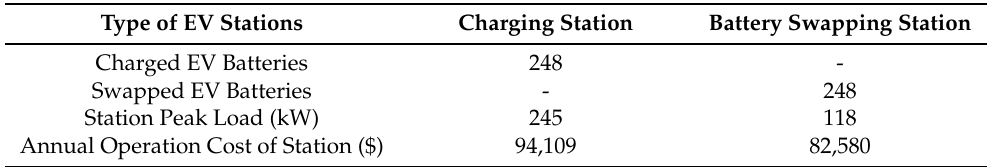
Table 1. EV station’s operation cost and peak